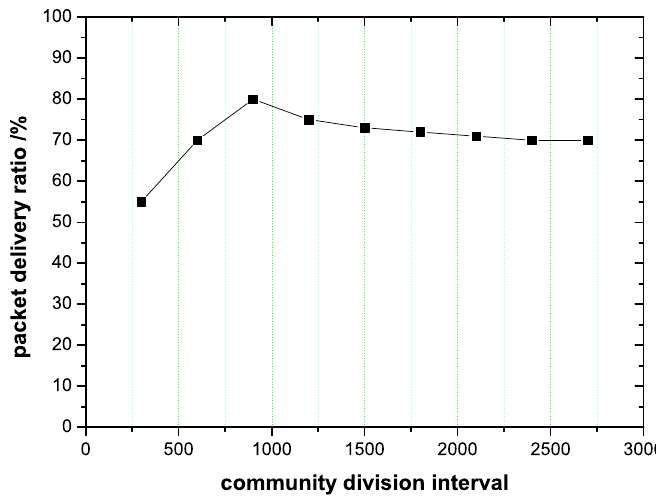
Figure 4. The influence of community division interval on packet delivery